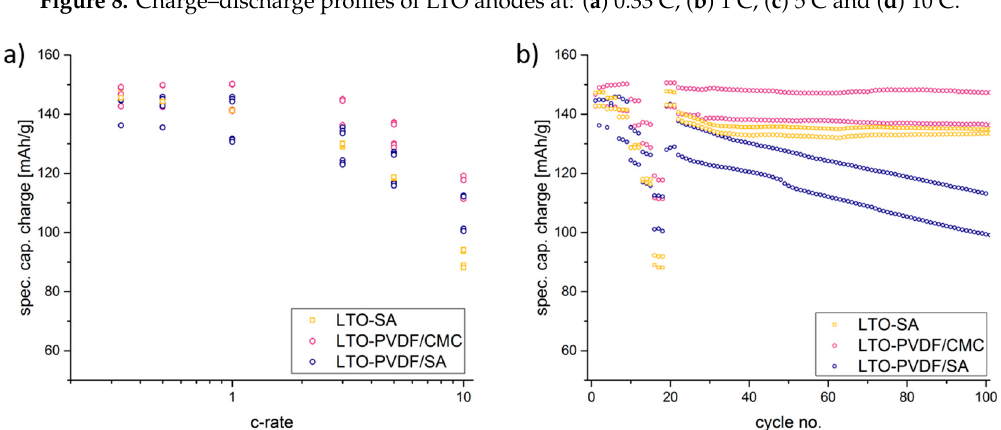
Figure 9. Electrochemical performance during C-rate test ( a ) and charge capacities for each of 2 exemplary electrodes ( b ).